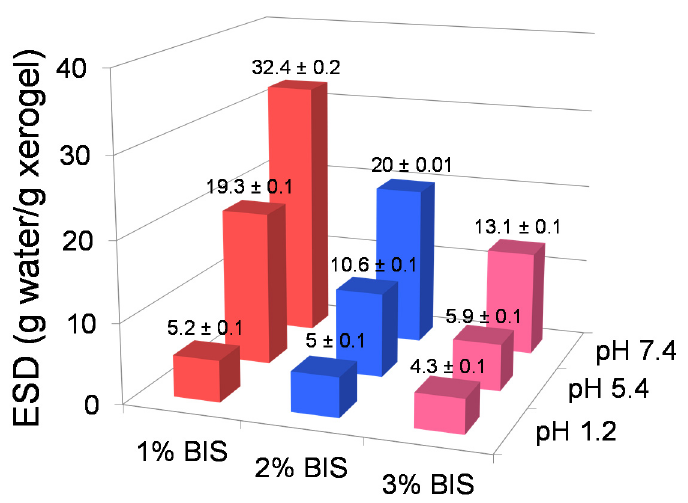
Figure 4. The influence of the crosslinking agent concentration on the swelling degree (72 h) at different pH values. The results are the average values ± standard errors. Hydrogel composition: BIS, 10% MAA based on the whole hydrogel composition, 0% MMT.